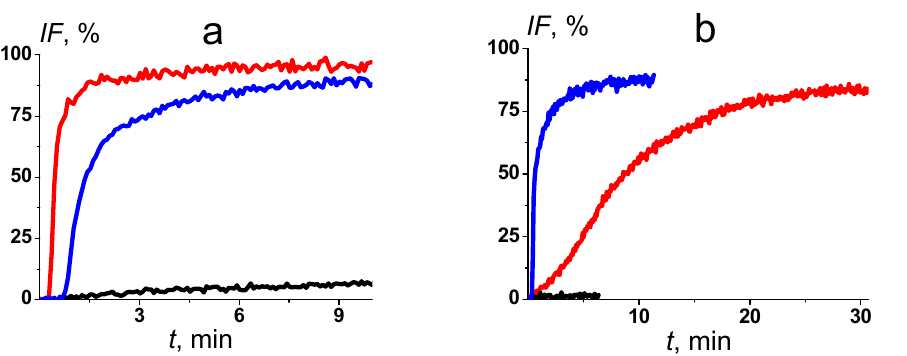
Figure 4. Time dependence of the relative fluorescence of calcein ( IF , %) leaked from DOPC ( a ) and DOPG ( b ) vesicles induced by addition of compounds 4 (black curves), 20 (blue curves), and 22 (red curves) up to 5 µ g/mL.